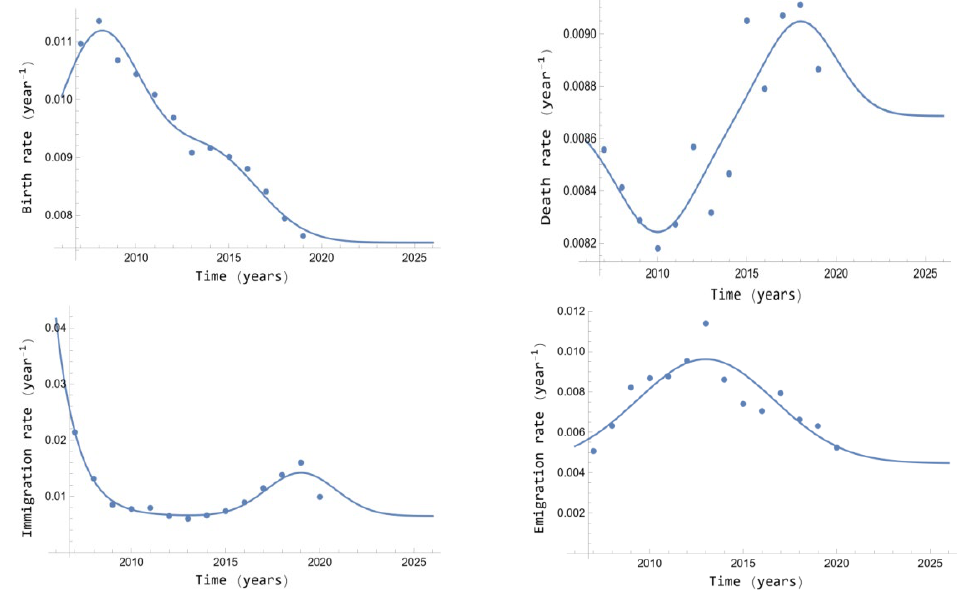
Figure 1. Change rates versus time in Spain: 2007–2026 period. Experimental values (dots) and theoretical values (line).